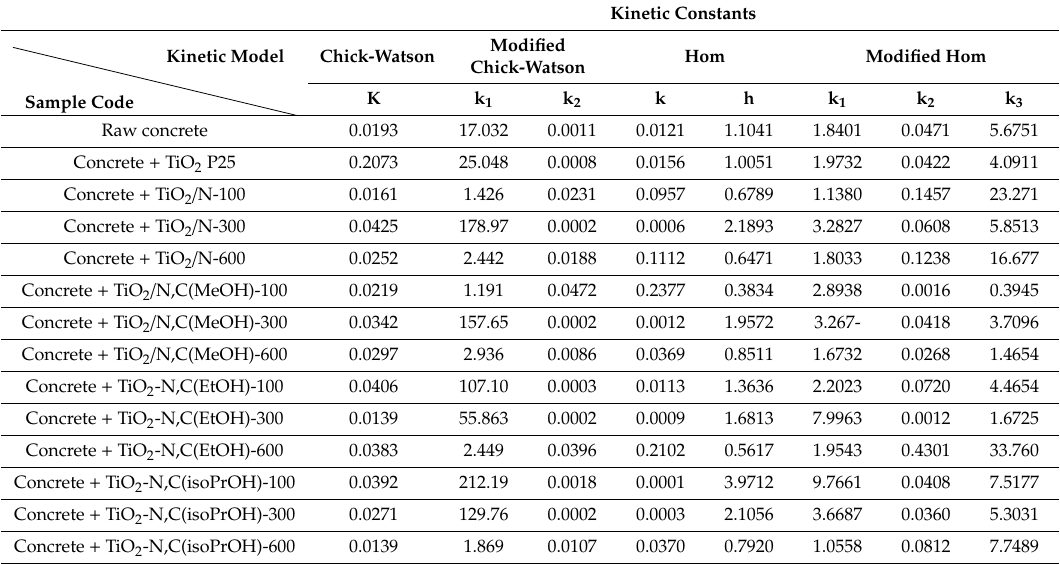
Table 5. Kinetic constants obtained from the kinetic analyses of four models for E. coli inactivation under artificial solar light